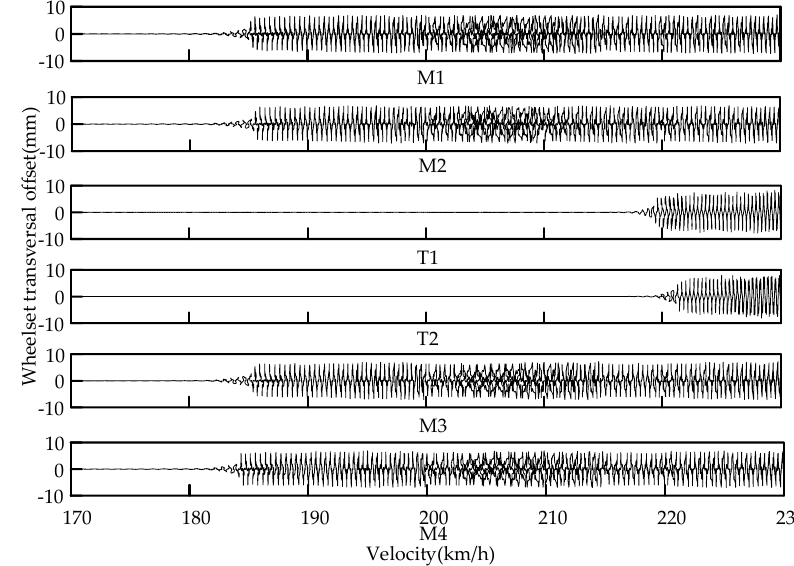
Figure 9. Nonlinear critical speed of each car of the marshaling urban rail train. Each curve represents the convergence rate of transverse movement of each carriage respectively.